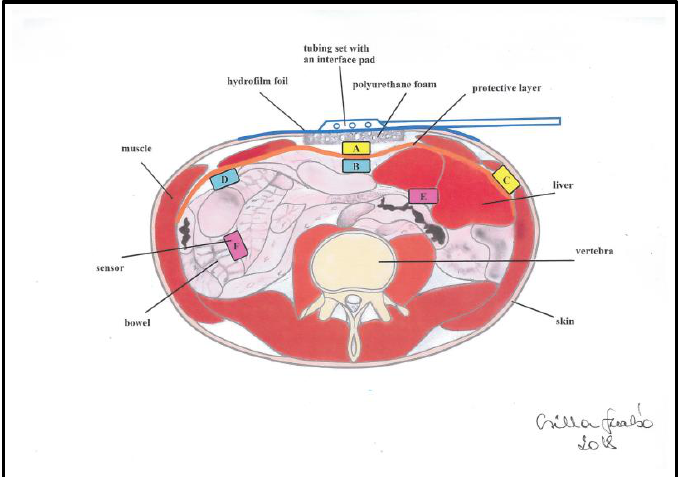
Figure 2. Schematic image of the strategic positioning of six pressure sensors in the abdominal cavity used for intra-abdominal pressure measurement in an experimental animal model. A: midline, above the layer; B: midline, under the layer; C: laterally, above the layer; D: laterally, under the layer; E: midline, among the bowels; F: laterally, among the bowels.